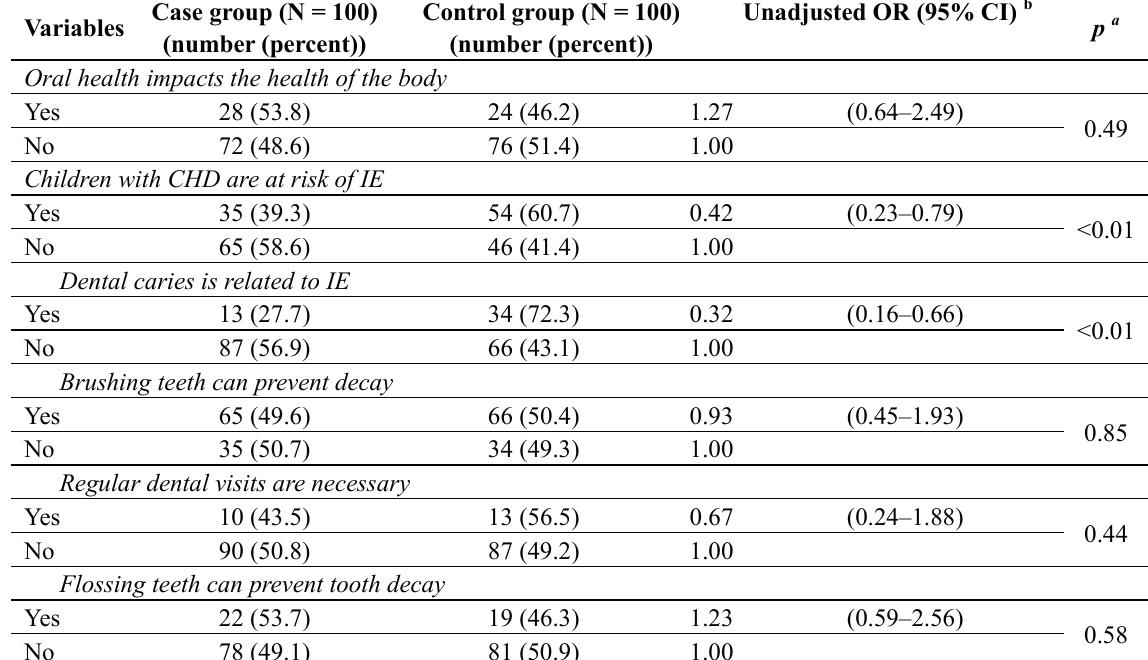
Table 2. Odds ratio for conditional logistic regression between parental knowledge from primary